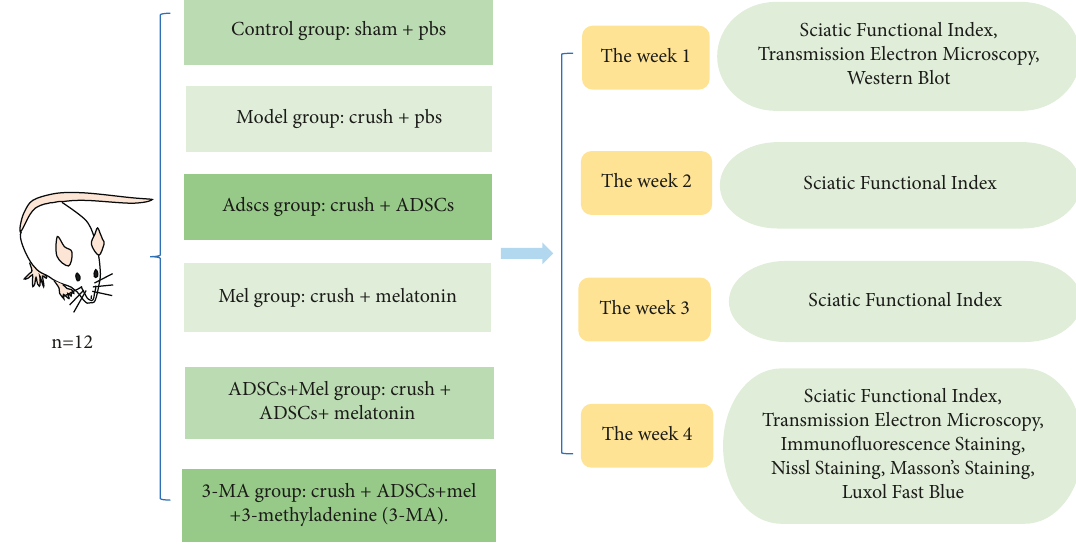
Figure 3: Grouping of